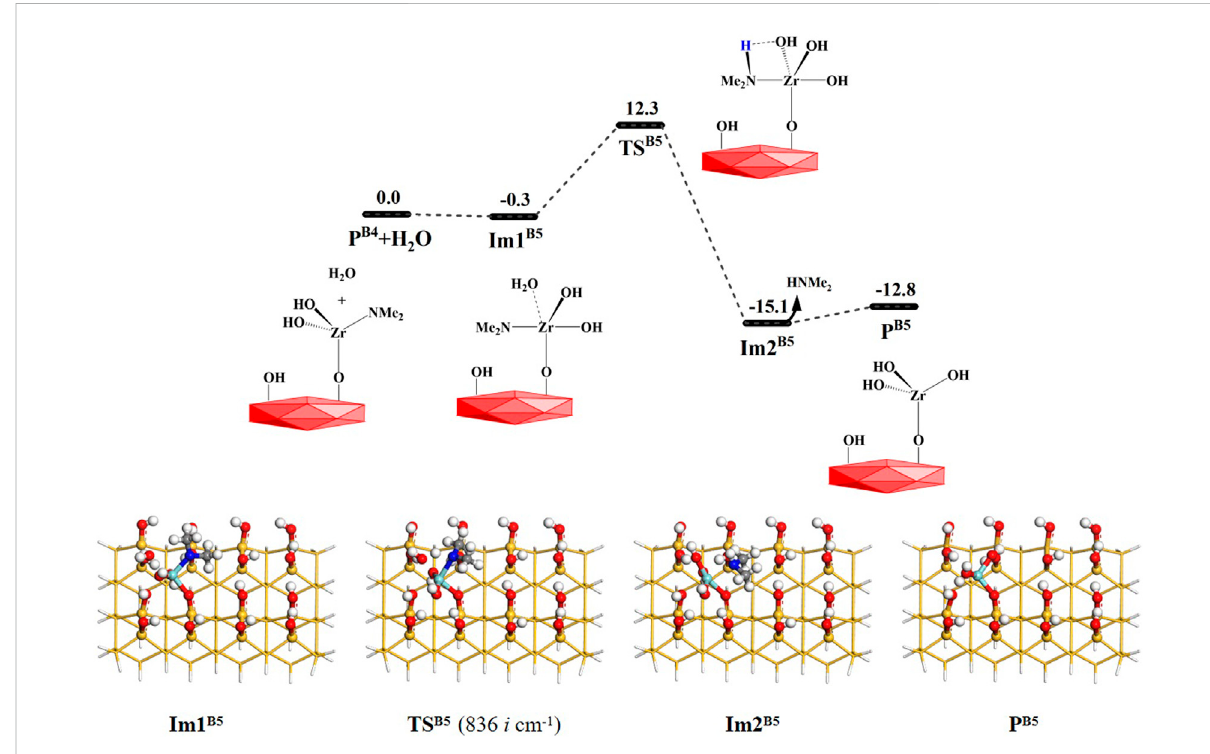
FIGURE 9 Gibbs free energy ( Δ G , kcal/mol) pro fi les of the B5 section of the H 2 O reaction with the aminated surface.